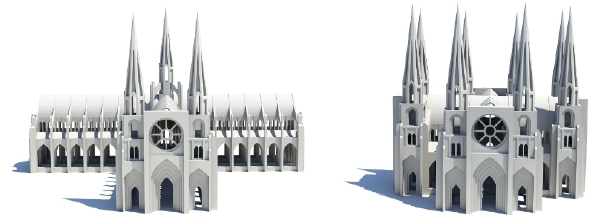
Figure 5: Gothic architecture is defined by strict rules with its characteristics. The generative description of Gothic cathe- drals encodes these building blocks and the rules on how to combine them. These building blocks have been created by M ICHAEL C URRY ,